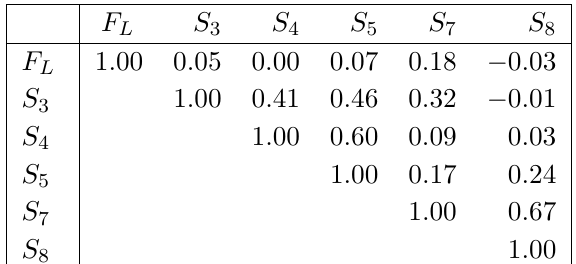
Table 12 . Statistical correlation matrix for the F